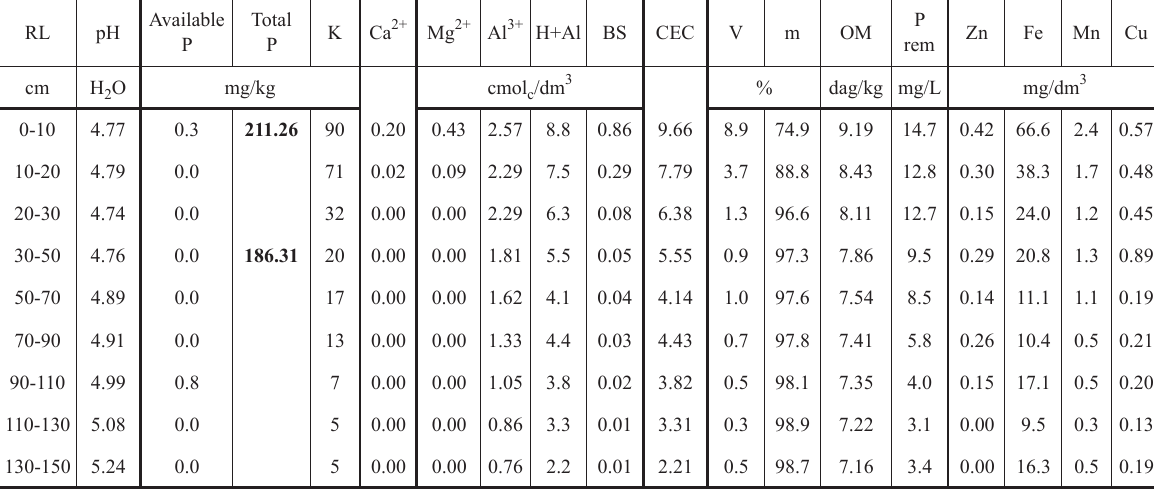
Color and morphological traits were obtained at 0-20cm and 40-60cm depths. OM: organic matter; CEC: cation exchange capacity;